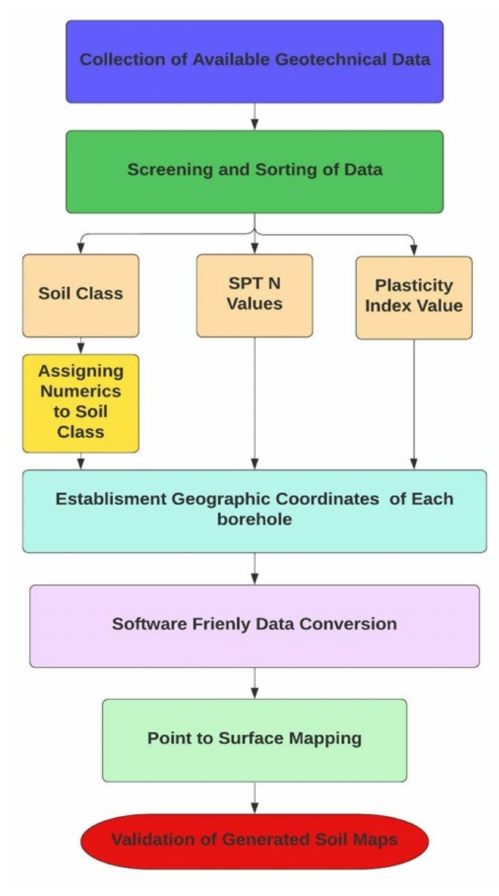
Figure 2. Flowchart of methodology.